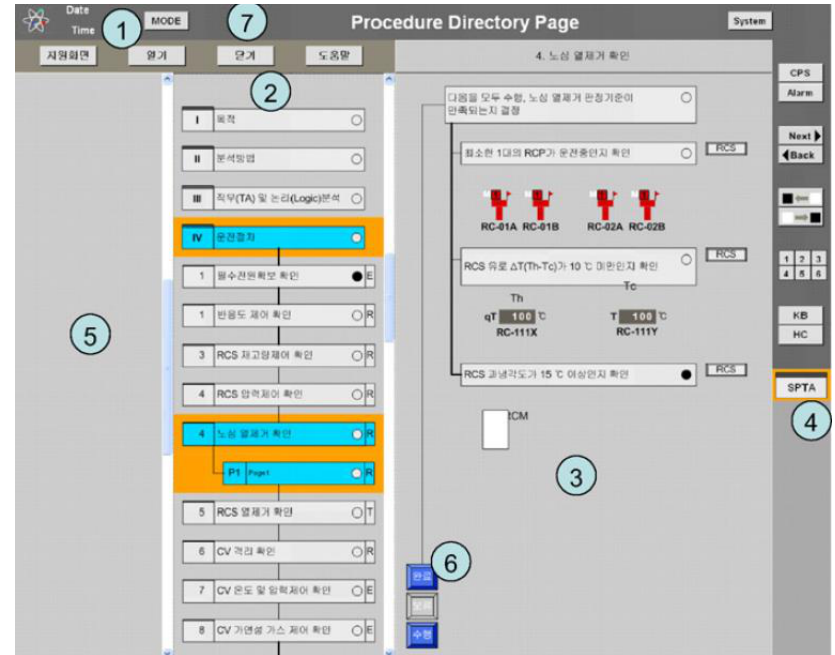
Figure 3. The main display of CPS. Reprinted from Nuclear Engineering and Design , Vol. 239,